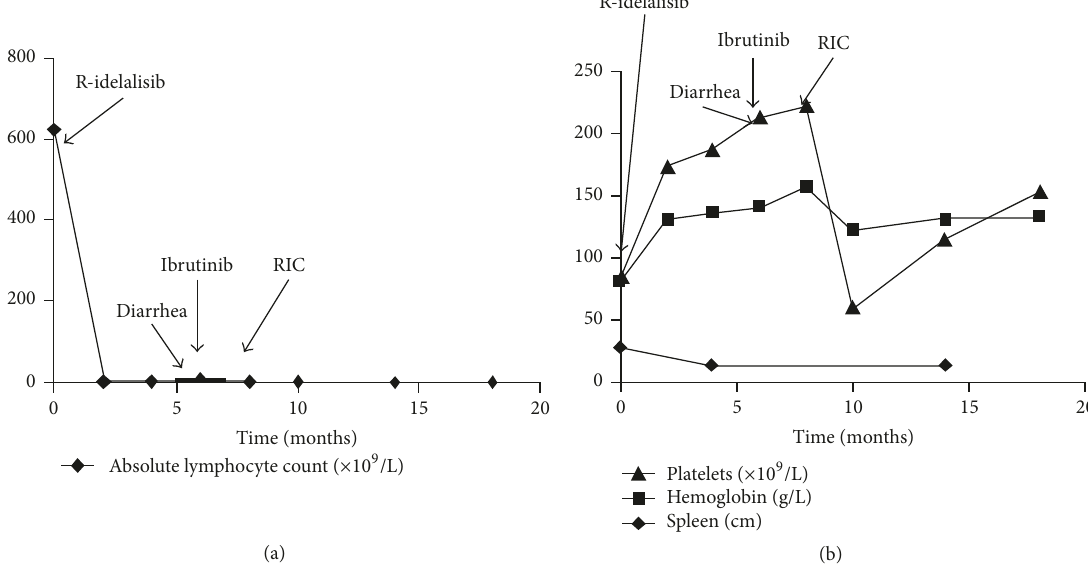
Figure 2: Response to idelalisib-rituximab started on day 0, ibrutinib started in month 6, and reduced-intensity conditioning allo-HSCT was performed in month 8. (a) Absolute lymphocyte count. (b) Platelet count, hemoglobin concentration, and spleen size (measured by CT scan/longest